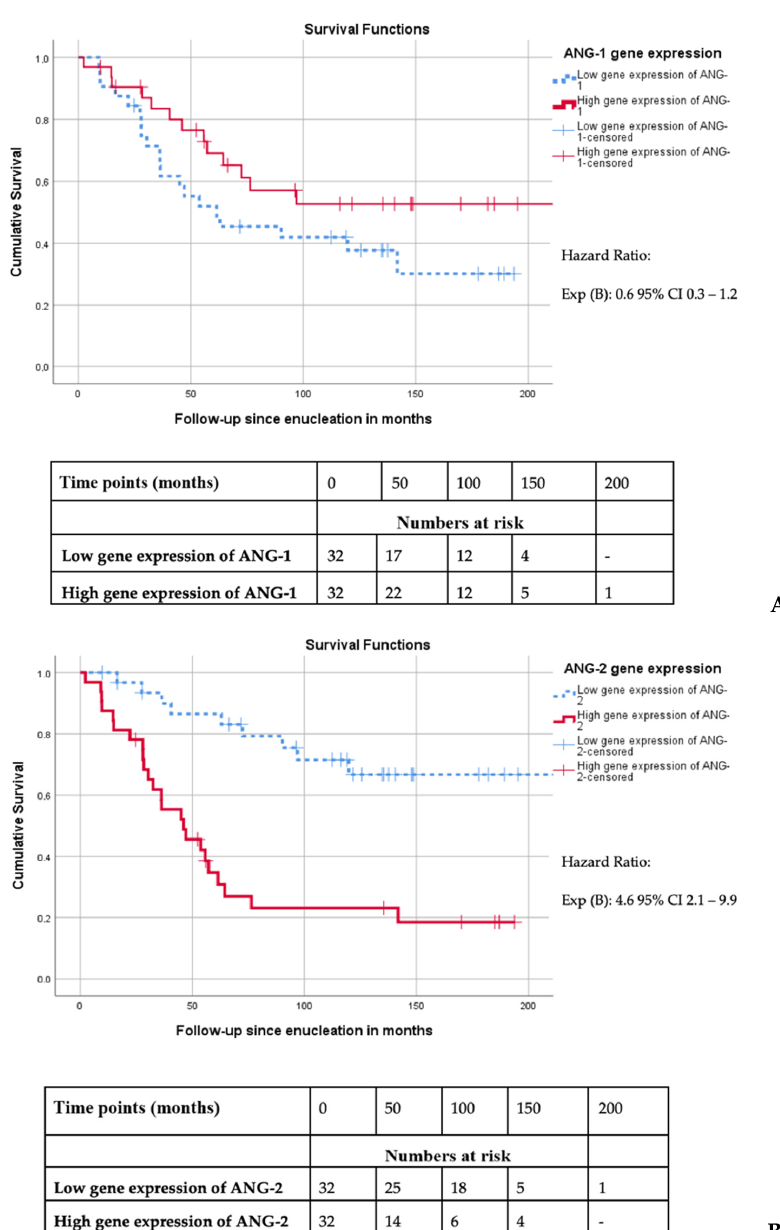
Figure 1. ( A ) Survival curve of UM-related survival dichotomized according to the median mRNA expression of ANG-1 in primary uveal melanoma ( n = 64, Log Rank p = 0.12). ( B ) Survival curve